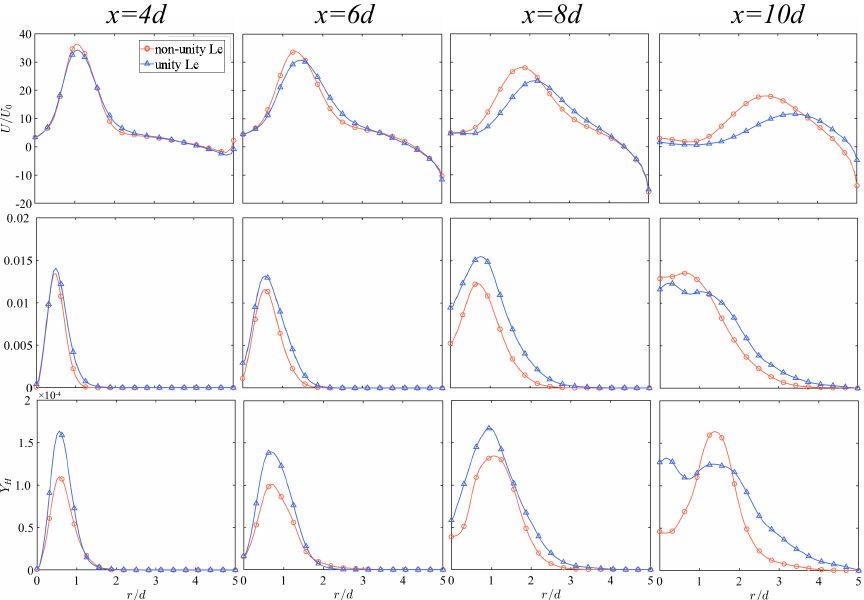
Figure 9. Radial profiles of mean quantities for the three cases at different axial locations: x = 4 d , x = 6 d , x = 8 d , x = 10 d